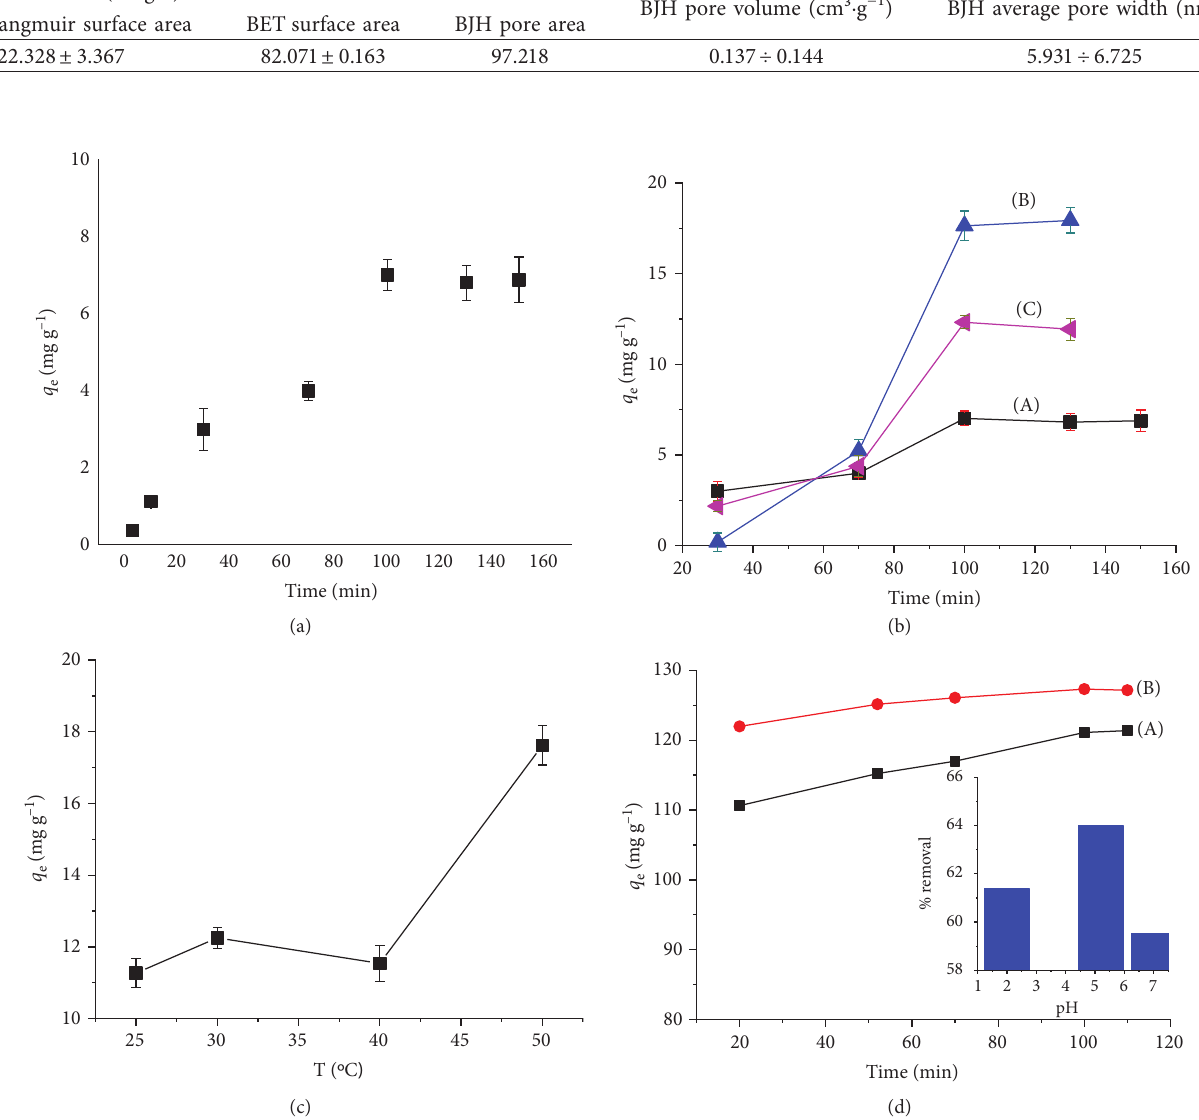
Figure 2: Optimization conditions for adsorption Co 2+ ion onto GO/PVA/Fe 3 O 4 nanocomposite: (a) effect of contact time, (b) effect of the adsorbent dosage: (A) 0.03 g; (B) 0.02g; (C) 0.01g, respectively, (c) effect of temperature, and (d) effect of pH: (A) pH 2 and (B) pH 5.2 (inserted image: % removal of samples vs. pH). Table 2: The effect of K + as an interfering ion to the adsorption